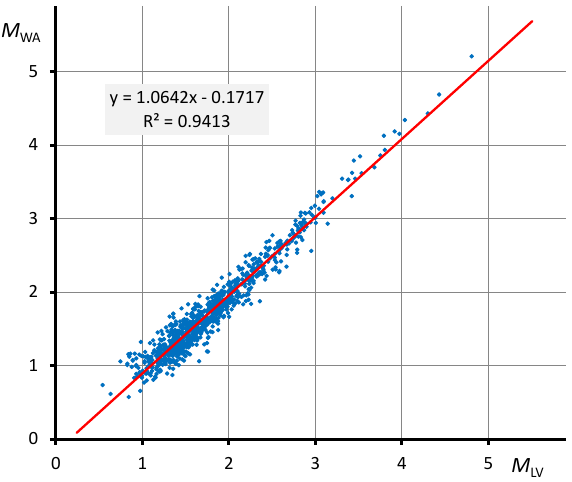
Fig. 5. Comparison of the new M WA and original M LV magnitudes for the earthquakes, used in the inversion.